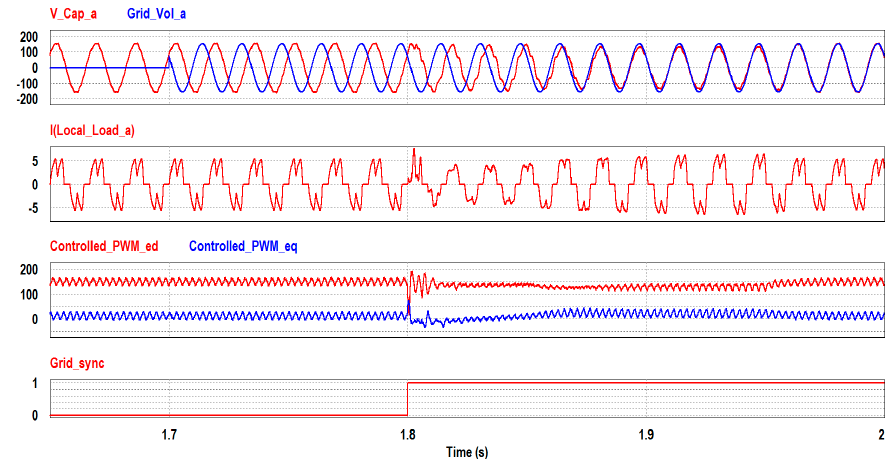
Figure 13. Simulation results in Case III. (SBGS ⟶ GS Mode) (From top to bottom: Measured a -phase inverter output voltage and grid voltage, a -phase local load current, PWM d - q controller outputs, and GS status signal).